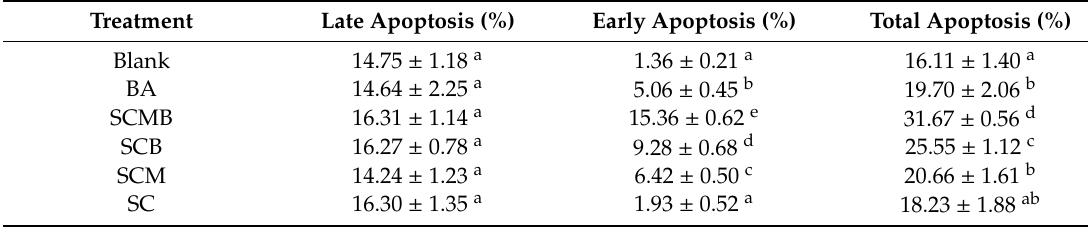
Figure 7. Effect of different treatments on the apoptosis of HepG2 cells. ( A ) Blank; ( B ) BA; ( C ) SCMB; ( D ) SCB; ( E ) SCM; ( F ) SC. FL1-H is the tunnel to collect Annexin V-FITC signal and FL2-H is the tunnel to collect PI signal. Table 2. The comparison of apoptosis rate under different treatments.